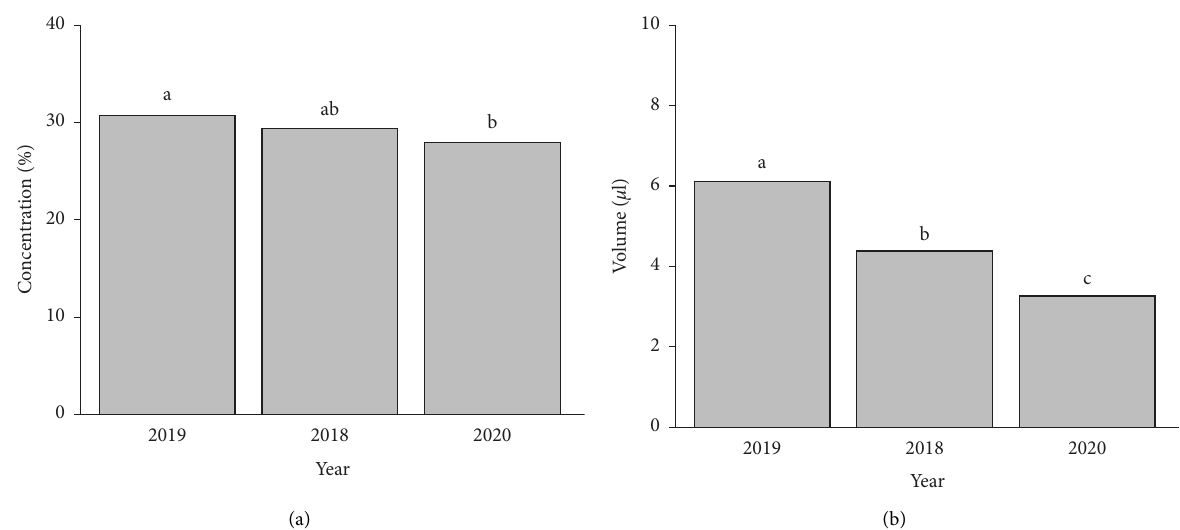
Figure 4: Nectar concentration (a) and volume (b) of Salvia leucantha from 2018 to 2020 years in southwest Shewa Zone, Ethiopia.